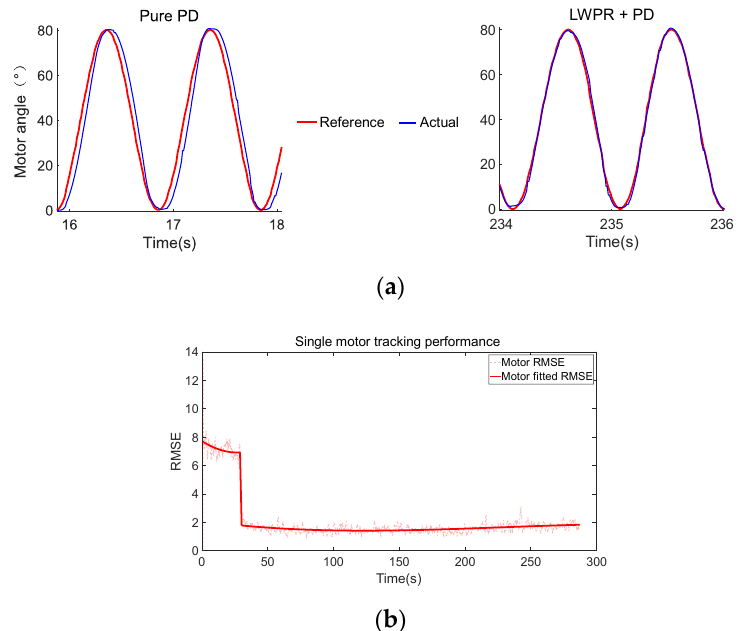
Figure 5. ( a ) Motor’s position tracking under different modes. ( b ) Tracking performance of single motor.